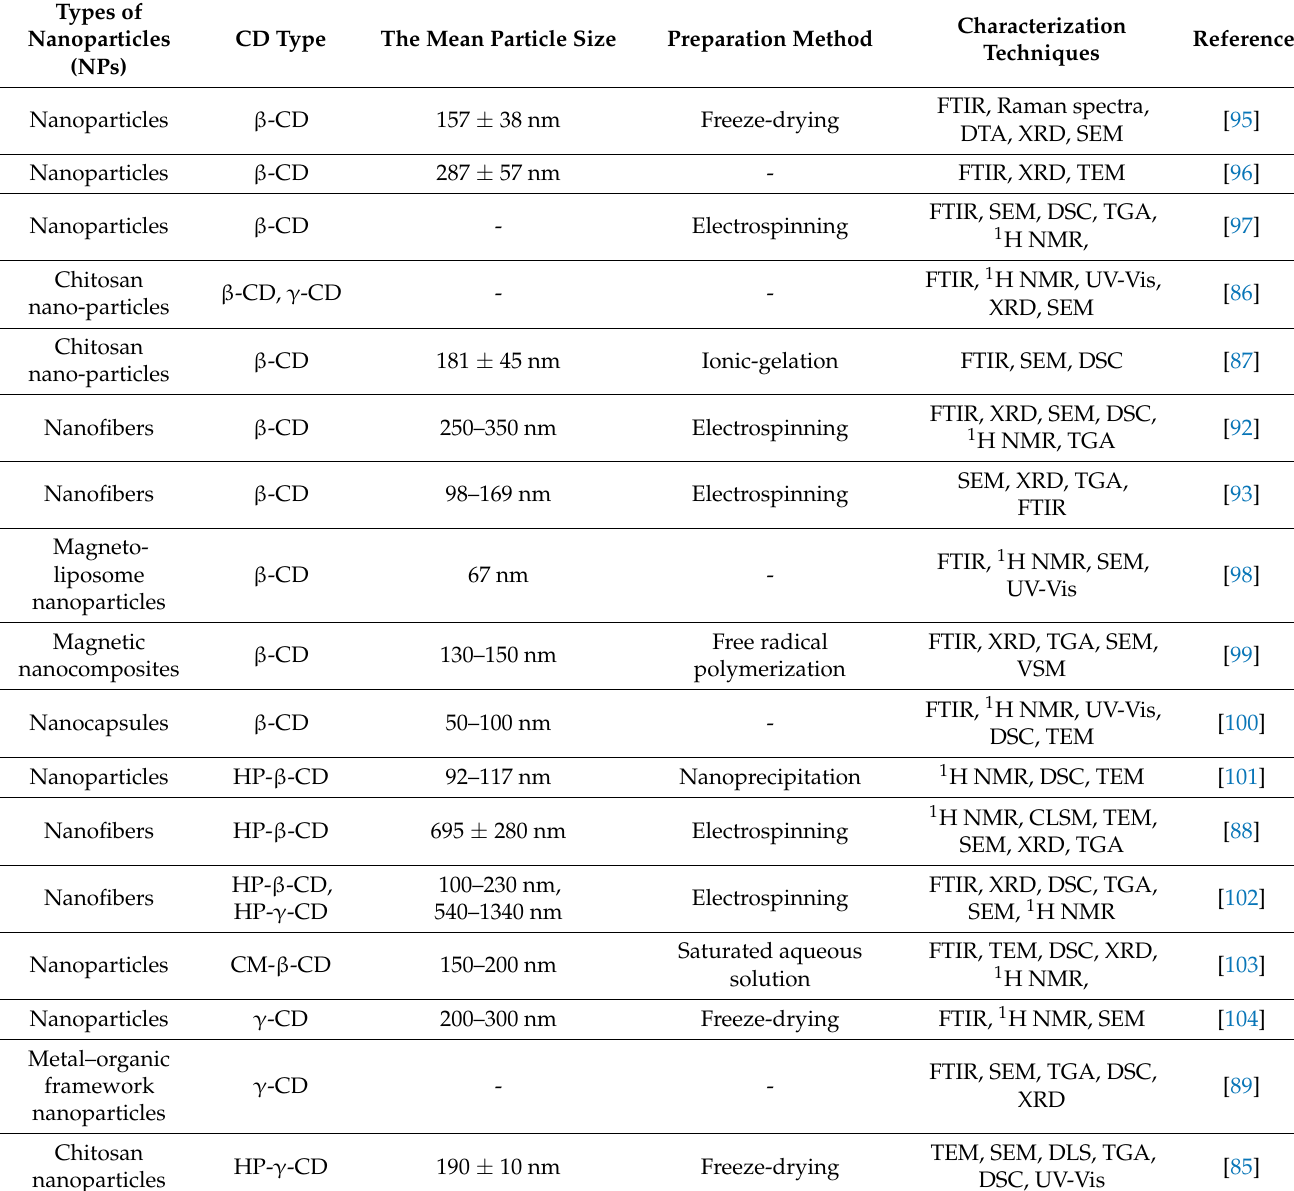
Table 3. Summarized articles related to nano-systems containing cyclodextrins encapsulated with